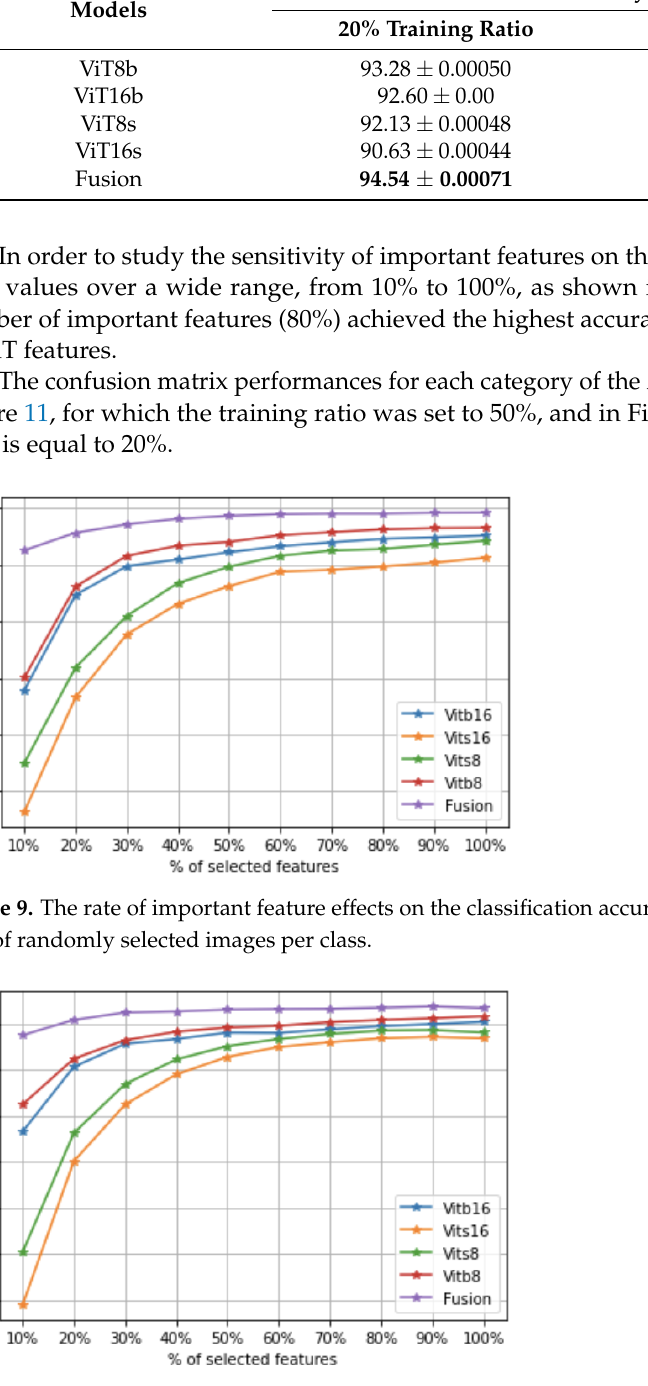
Figure 10. Rate of important feature effects on the classification accuracy of the AID data set with 50% of randomly selected images per